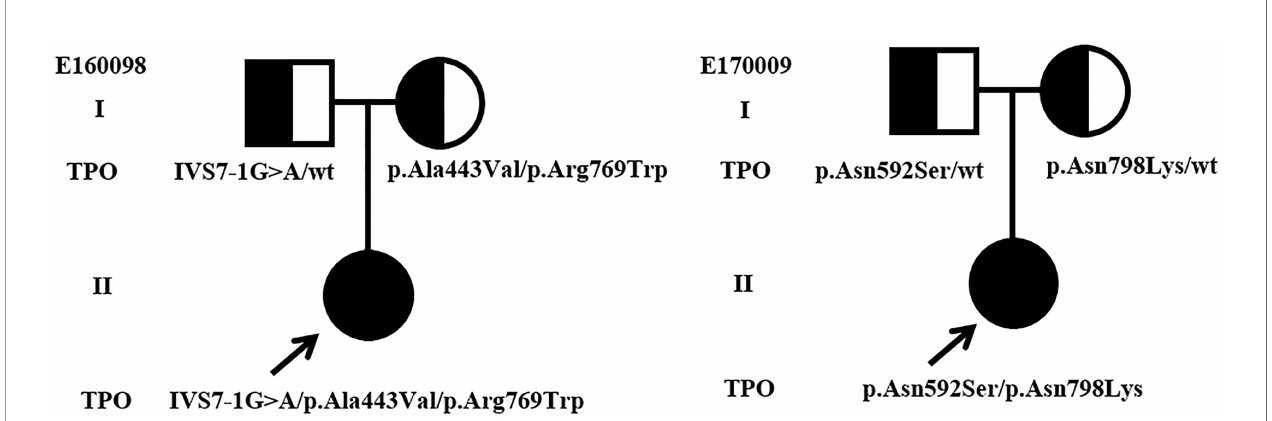
FIGURE 1 | Genotypes and pedigrees of two CH patients. Arrow, Proband; Roman numbers, generations; squares, males; circles, females; half- fi lled symbols, unaffected heterozygote individuals.